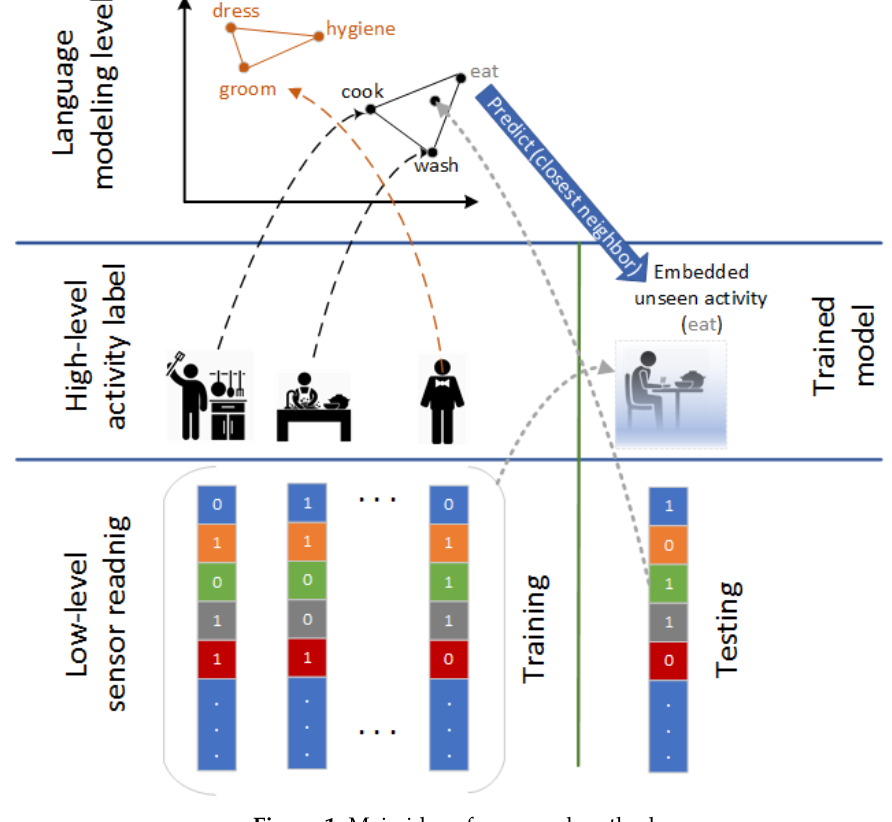
Figure 1. Main idea of proposed method. Algorithm 1: Preprocessing